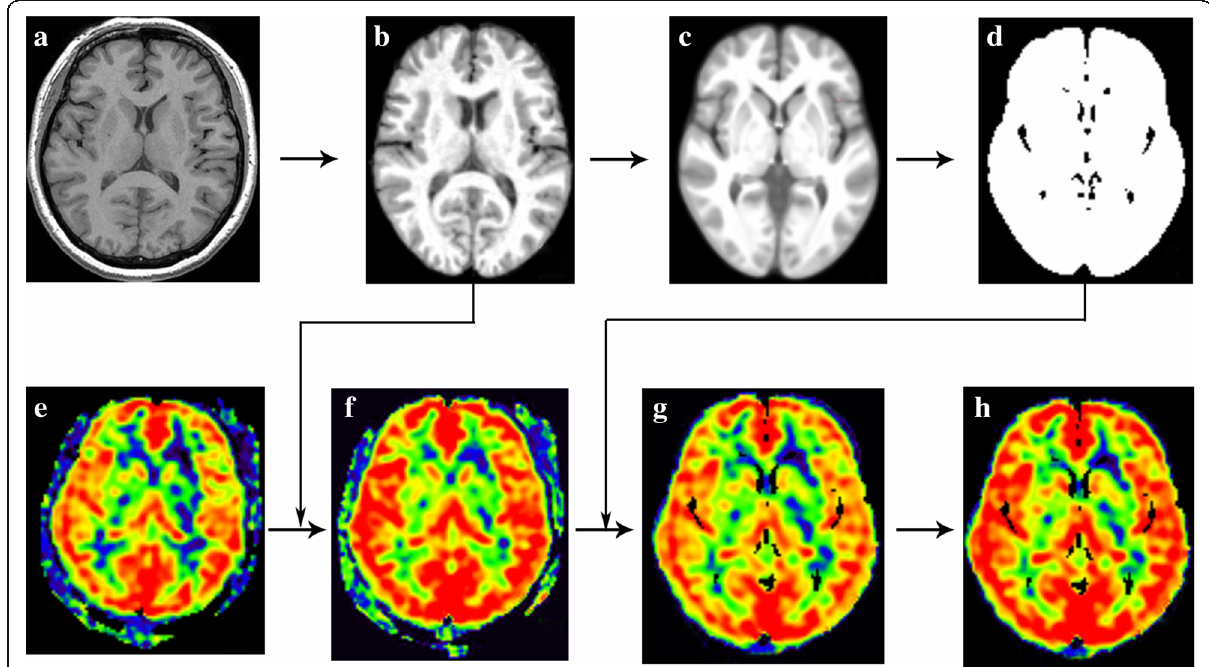
Fig. 1 Methods of CBF normalization and standardization. The individual raw T1 images ( a ) were segmented and generated T1 tissue probability maps ( b ), which would be used to generate average T1 tissue probability maps ( c ) and brain mask ( d ). The individual CBF maps ( e ) was coregistered by the T1 tissue probability maps, which would generate normalized CBF maps ( f ). The brain mask was applied with the normalized CBF maps in order to extract the brain tissue ( g ), and the Z transformation was performed with the normalized CBF maps to standardize the CBF maps ( h